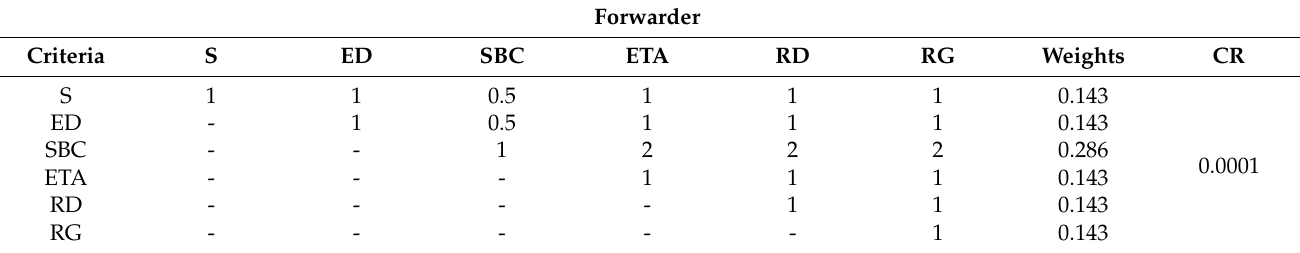
Table 1. AHP pairwise comparison matrix and weights [29]. S: slope; ED: extraction distance; SBC: soil-bearing capacity; ETA: extracted timber amount; RD: road density; RG: terrain roughness; CR: consistency ratio (must be < 0.1 for the AHP weights to be considered